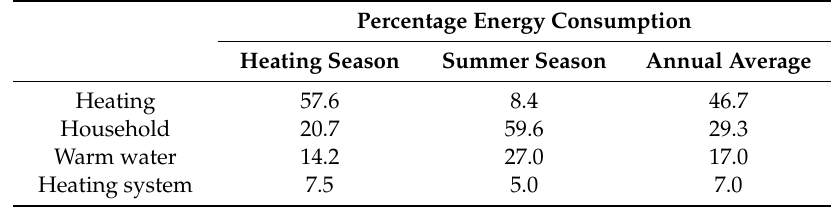
Table 1. Structure of energy use in seasons and year.